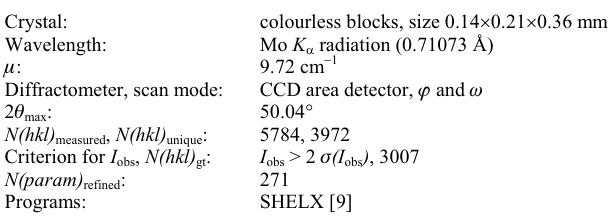
Table 1. Data collection and handling.